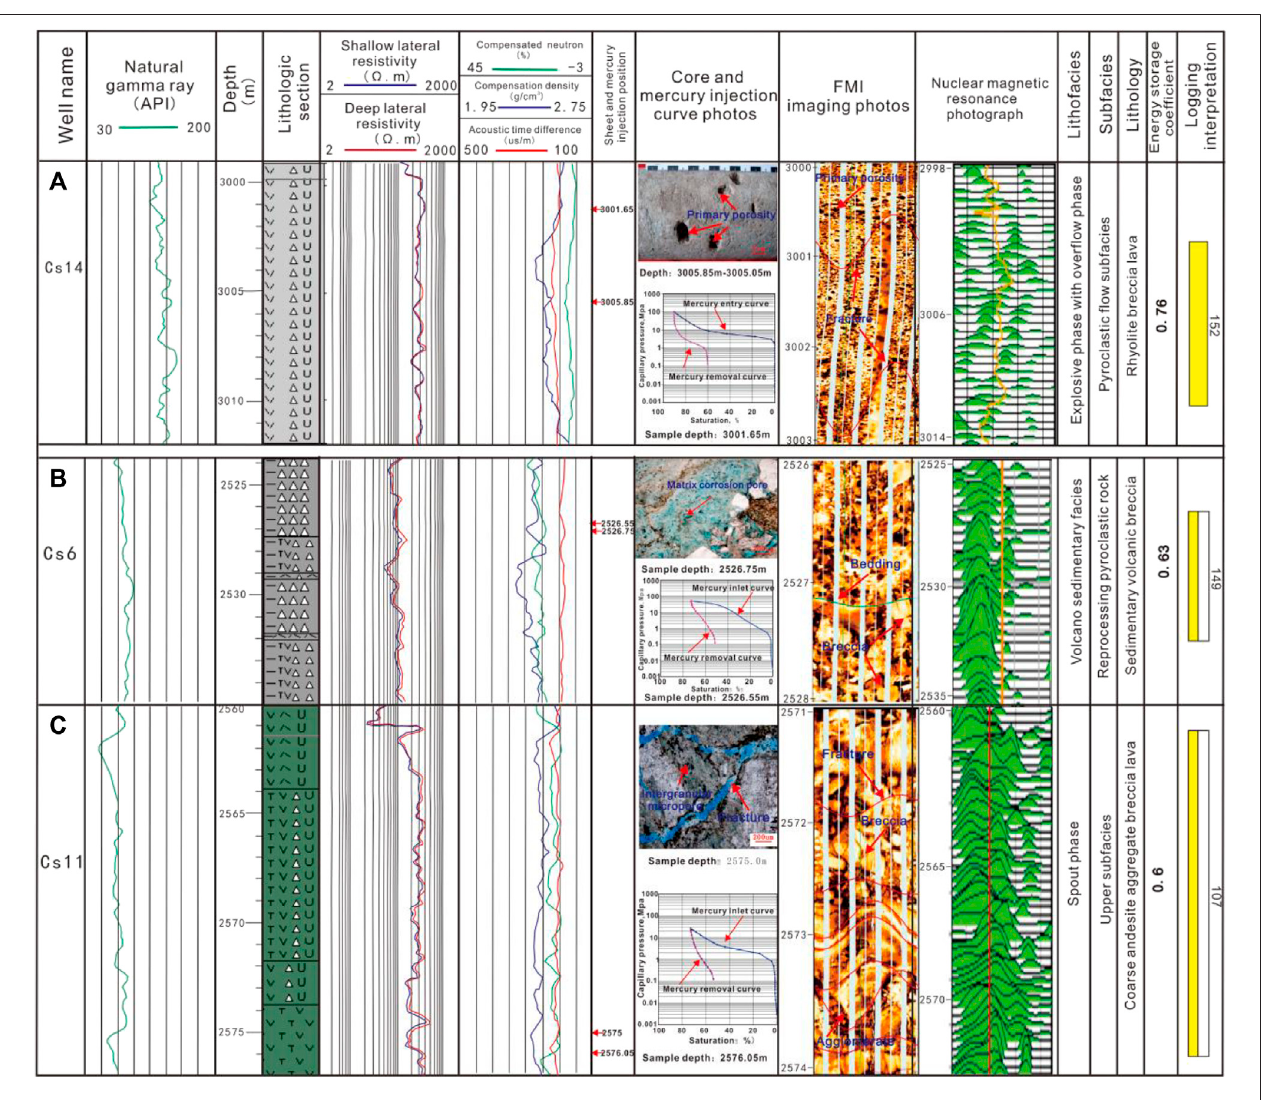
FIGURE 9 | Typical logging evaluation map of Type I volcano reservoir in the Wangfu Gas Field. Notes: (A) Well Cs14; (B) Well Cs6; (C) Well Cs11.